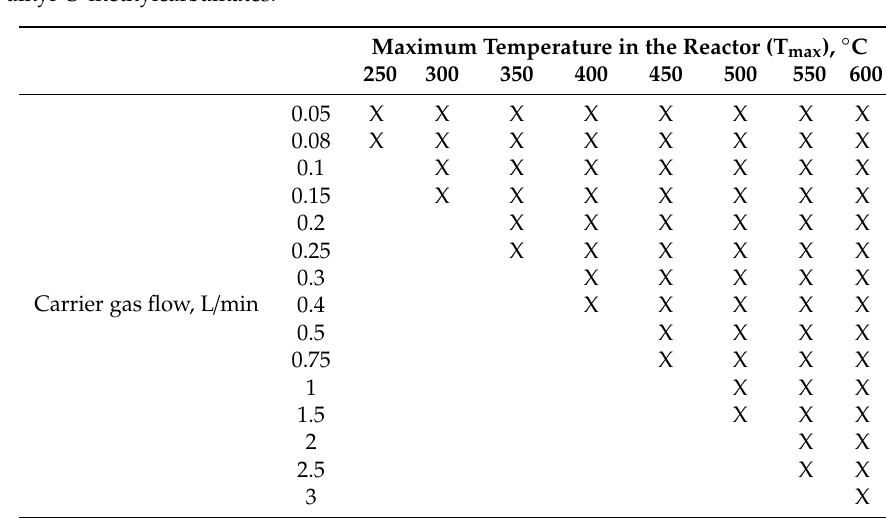
Table 2. Parameter range for a series of experiments on the thermal decomposition of N-alkyl-O-methylcarbamates.